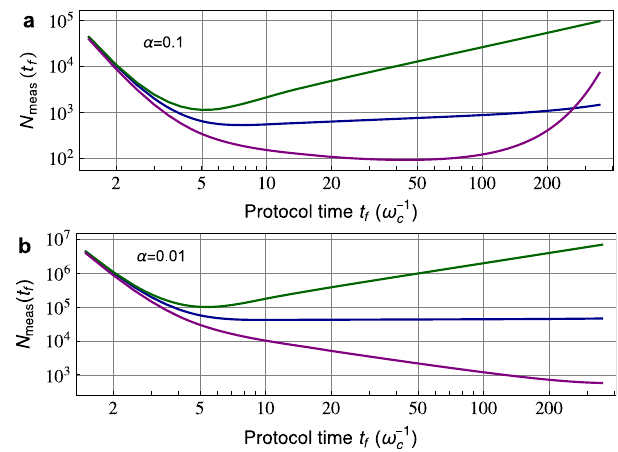
Fig. 3 Minimum number of measurements N meas needed to resolve the quench phase shift with a unit signal-to-noise ratio in a Hahn-echo (cid:4) (cid:4) (cid:4) (cid:4) (cid:2) 2 . Because of bath-induced protocol of time t f : N meas ð t f Þ (cid:4) h ^ σ y ð t f Þi dephasing, it will in general take many repeated measurements to resolve the quench phase shift (QPS). We use the same Gaussian baths (and labeling) as in Fig. 2. Panel ( a ) corresponds to a dimensionless coupling parameter α = 0.1, while ( b ) corresponds to α = 0.01. All plots correspond to a temperature k B T = 0.01 ω c